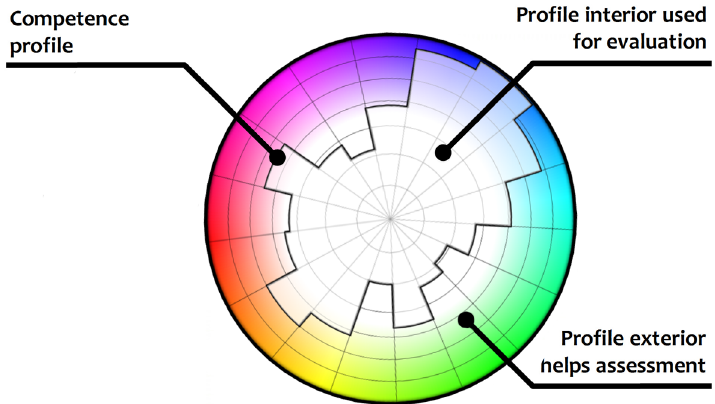
Figure 6. Blending evaluation and